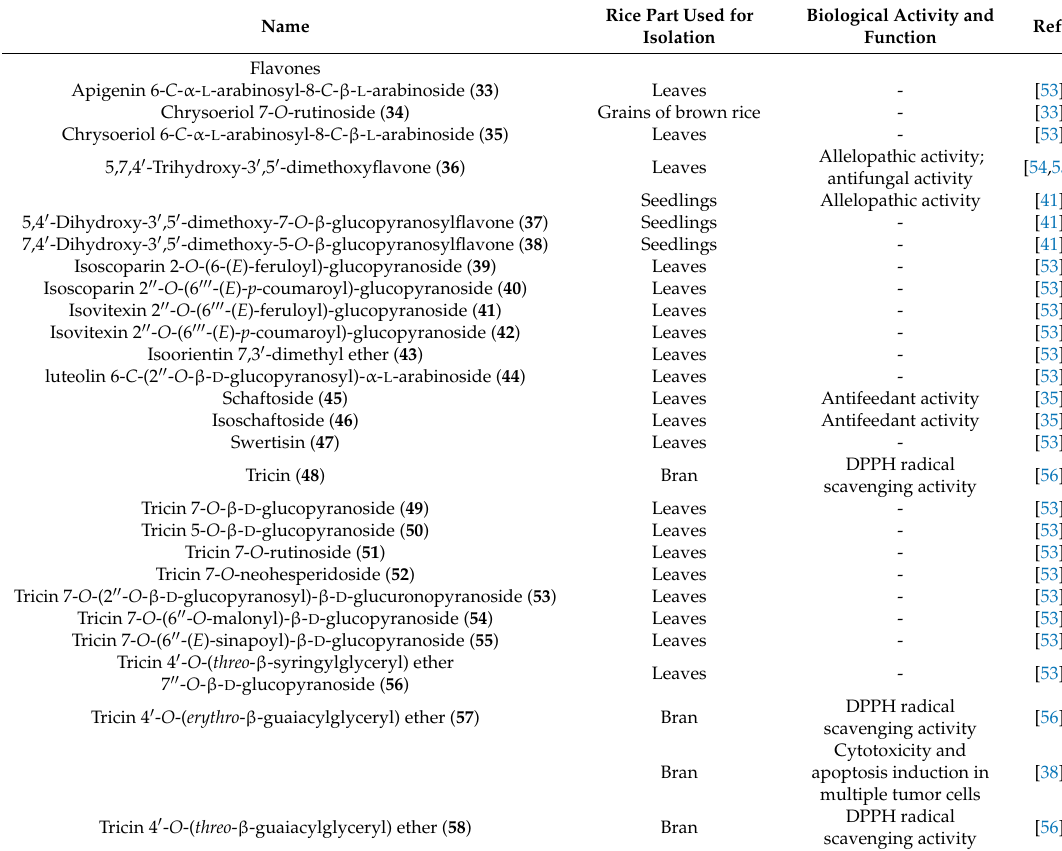
Table 2. Flavonoids and their biological